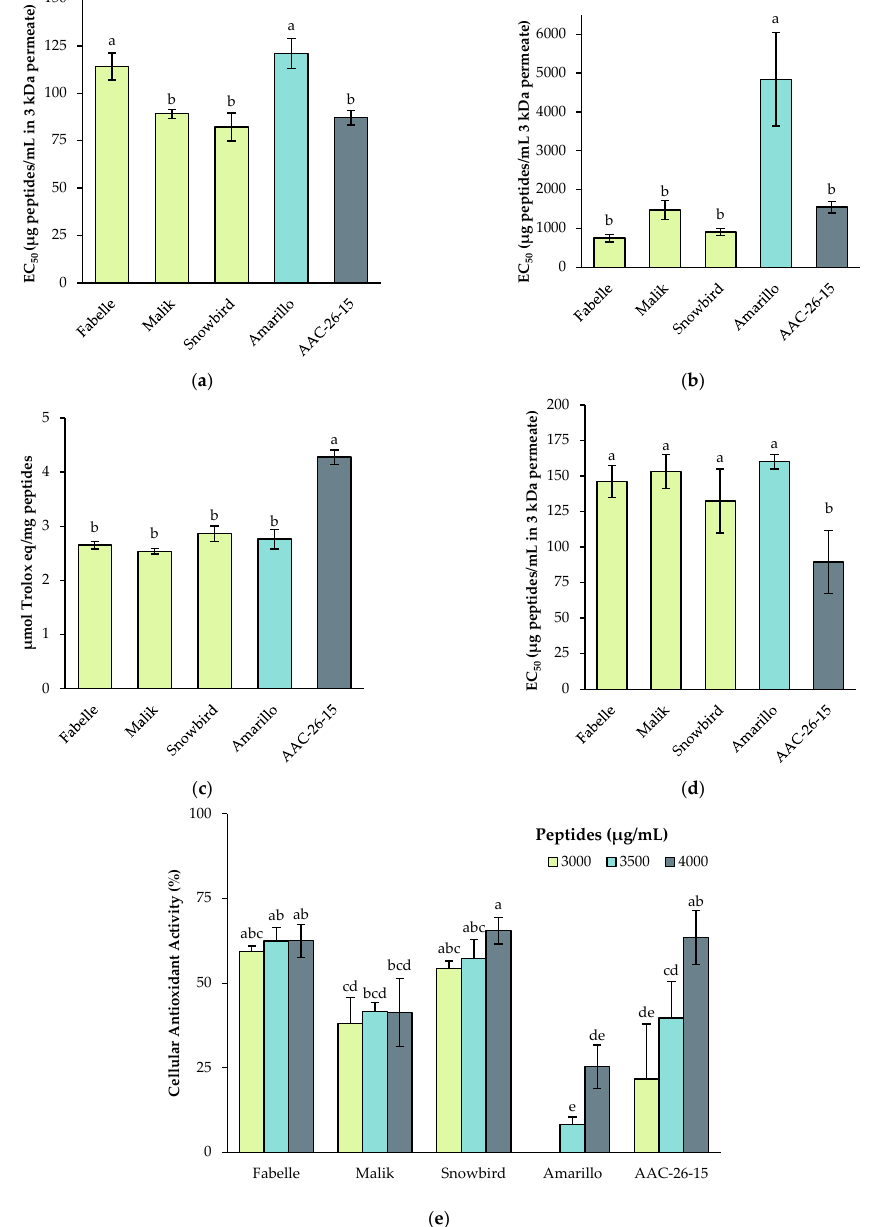
Figure 6. Antioxidant activity of the 3 kDa permeate of legume digestates as assessed by ( a ) the 2,2 (cid:48) - azinobis(3-ethylbenzothiazoline-6-sulfonic acid) (ABTS) assay; ( b ) the 2,2-diphenyl-1-picrylhydrazyl (DPPH) assay; ( c ) the oxygen radical absorbance capacity (ORAC); ( d ) the iron chelating assay; and ( e ) the cellular antioxidant assay (CAA). Data are expressed as mean ± standard deviation and means without a common letter differ ( p < 0.05) as analyzed by one-way ANOVA and the Tukey’s